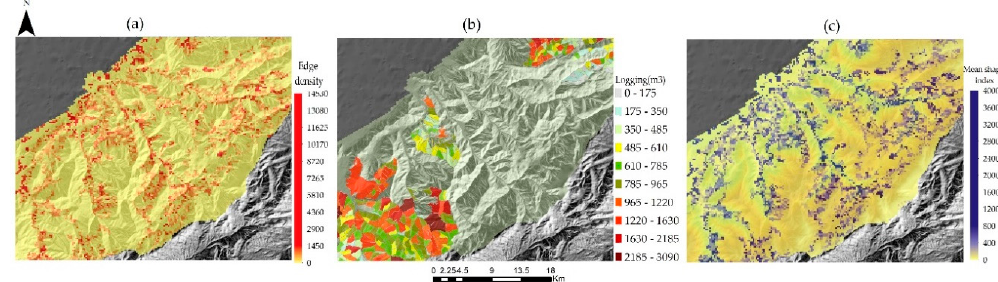
Figure 8. The top influential anthropogenic triggering factors for mapping landslide susceptibility in the non-protected forest, NE Iran: the edge density and mean shape index indicating the forest fragmentation induced by road-network expansion and forest conversion ( a,c ); and the aggregation of logging volumes ( b ) from 1970 to 2016.